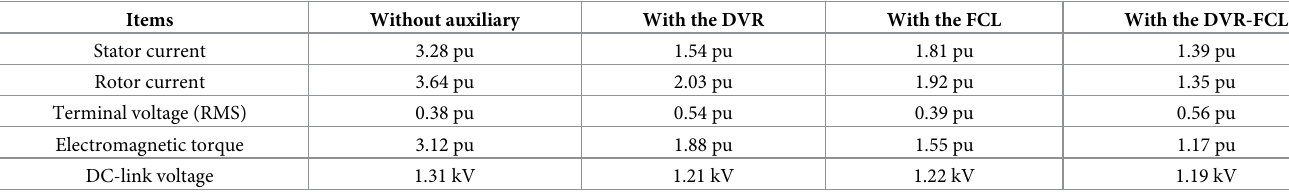
Table 3. Comparison of various methods on the DFIG subject to the asymmetrical fault.